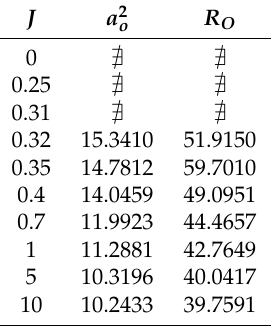
Table 1. Critical threshold of J , from which R O exists and convection occurs via an oscillatory state in the case { γ = 0.8, k r = 1.5, η = 0.2, T 2 =